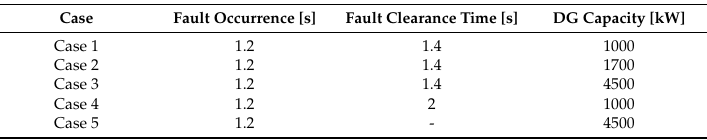
Table 1. Simulation